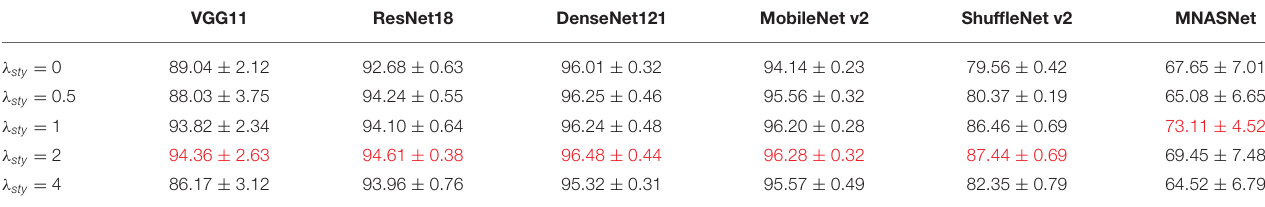
TABLE 4 | Ablation study of λ sty in image